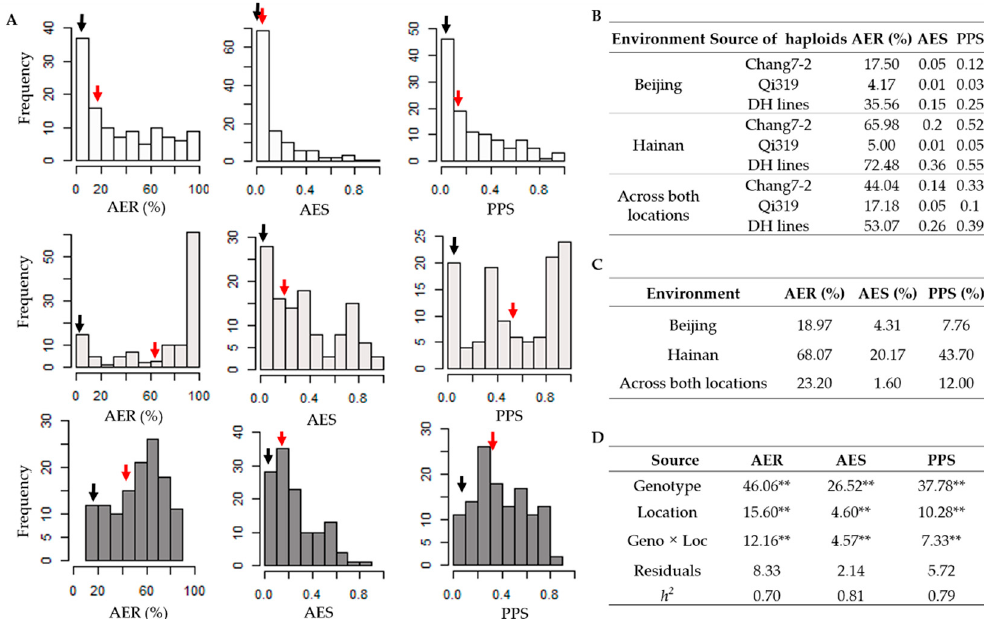
Figure 1. ( A ) The distribution of anther emergence rate (AER), anther emergence score (AES), and pollen production score (PPS) for the haploid mapping population grown in Beijing (white), Hainan (light gray) and across both locations (dark gray). Mean values of haploid male fertility-related traits for Qi319 (black arrows) and Chang7-2 (red arrows) were shown. ( B ) AER, AES and PPS of parental inbred line haploids at di ff erent locations. ( C ) The proportion of high male fertility (score of ≥ 70% for AER or ≥ 0.7 for AES and PPS) haploids for AER, AES and PPS. ( D ) Variation statistics and heritability ( h 2 ) of AER, AES and PPS in the haploid mapping population. ** p < 0.01.